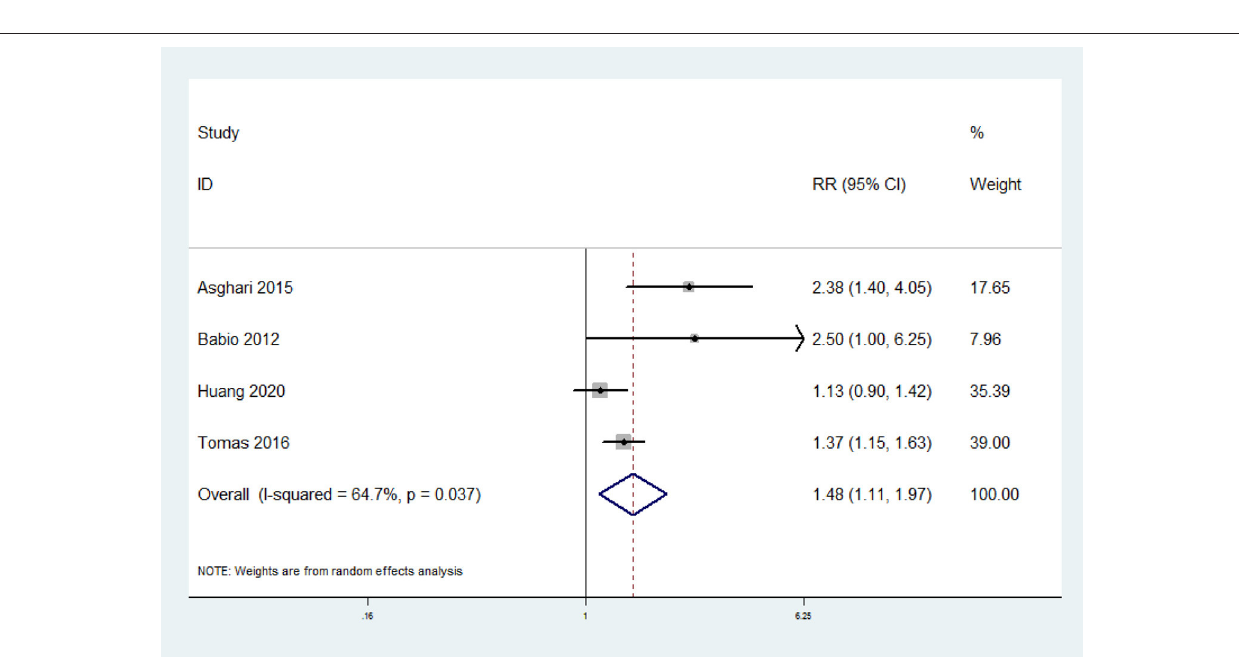
FIGURE 4 | Forest plot of meta-analysis: overall multi-variable adjusted RR of MetS for the highest vs. lowest category of processed red meat